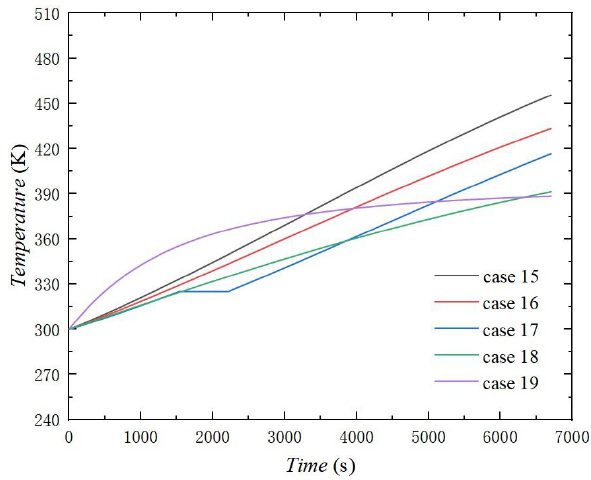
Figure 25. Temperature of accessory 2 when the casing, baffle and accessory were thermally pro- tected.